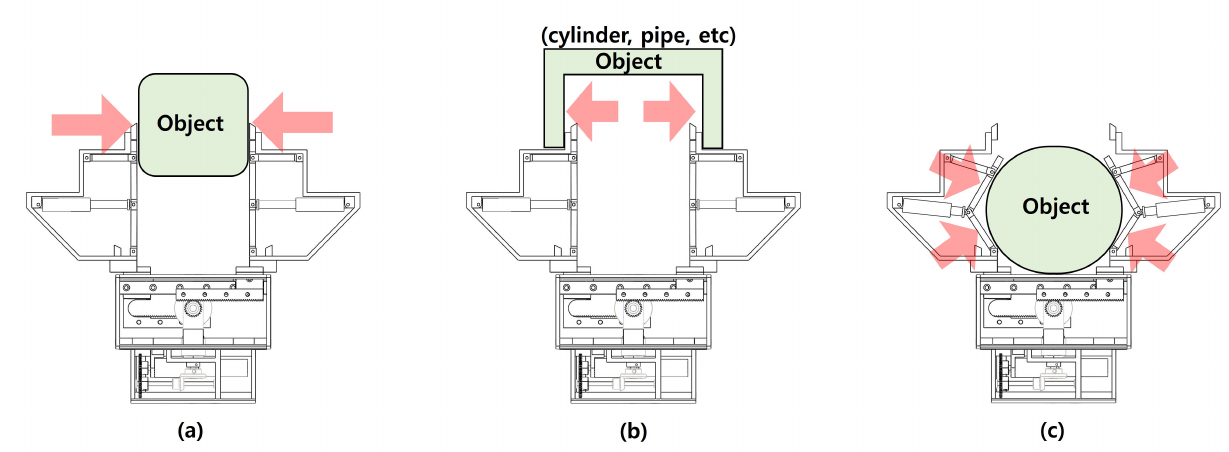
Figure 5. Grasp modes of self-adaptive grippers. ( a ) Pinch grasp mode. ( b ) Spread grasp mode. ( c ) Encompassing grasp mode.